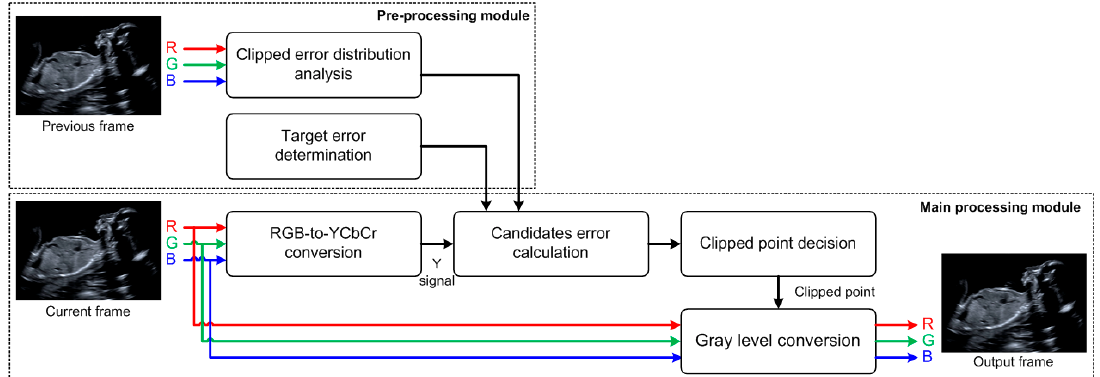
Figure 2. Overall block diagram of the proposed algorithm.